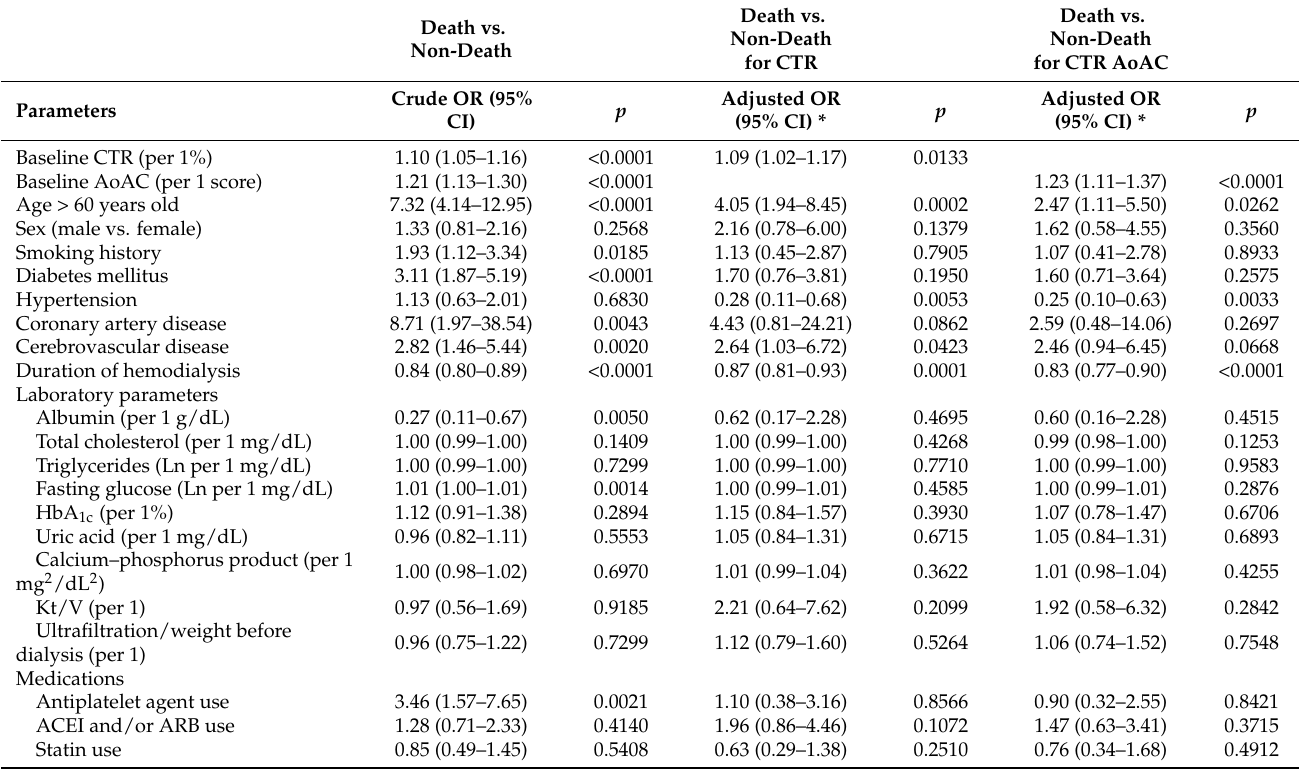
Table 7. Association between baseline CTR and AoAC with overall mortality.